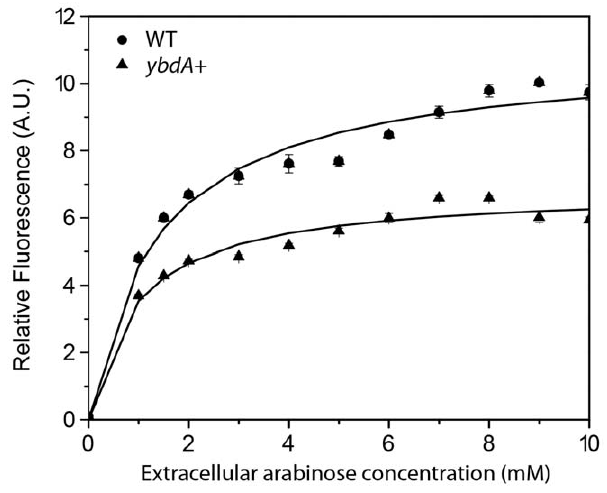
Figure 2. Dose-response curve for ybdA overexpression. P araB - venus in WT and ybdA overexpressing strains were measured for fluorescence and the results are reported as Fluorescence/OD 600 . Strains were induced with arabinose concentrations varying from 0 mM to